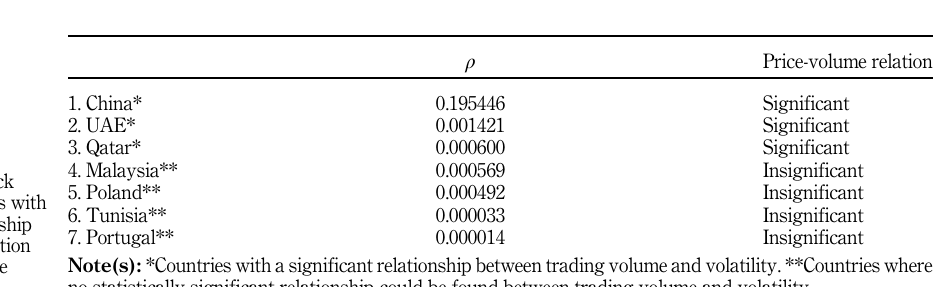
Table 8. Rankings of stock exchange indices with negative relationship between transaction volume and price changes